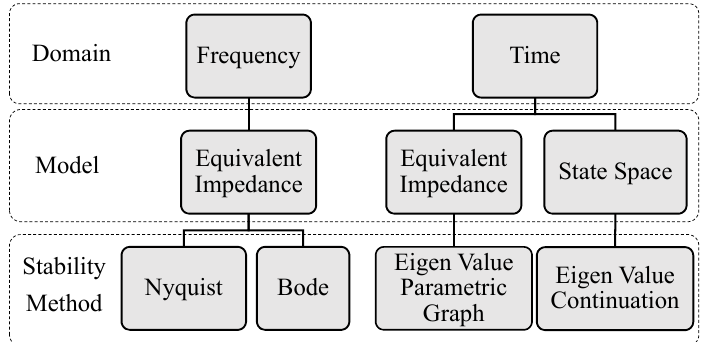
Figure 1. Methodology